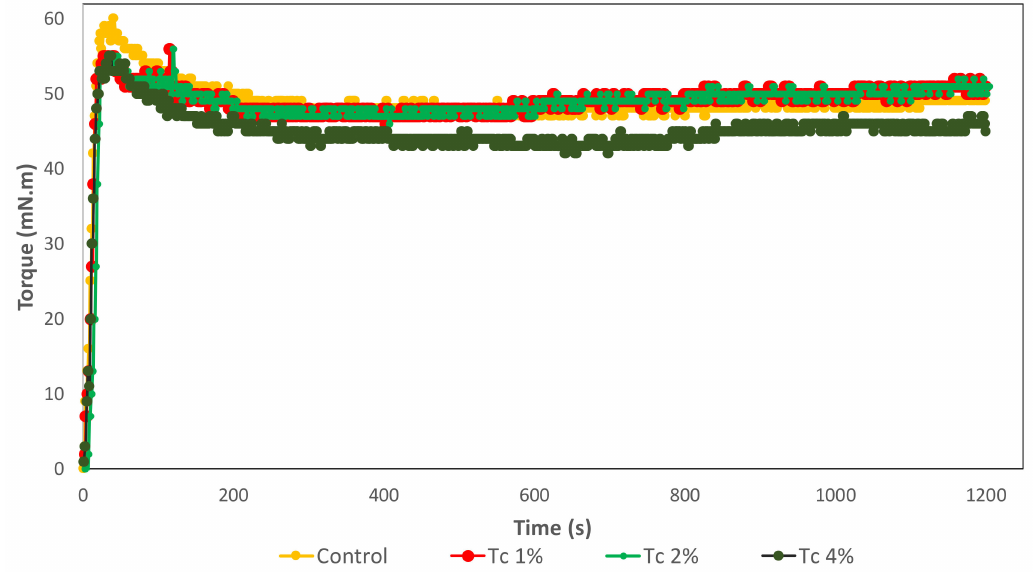
Figure 1. Mixing curves obtained from the Micro-doughLab of Control and GF doughs with T. chuii Tc 1%, Tc 2% and Tc 4%.